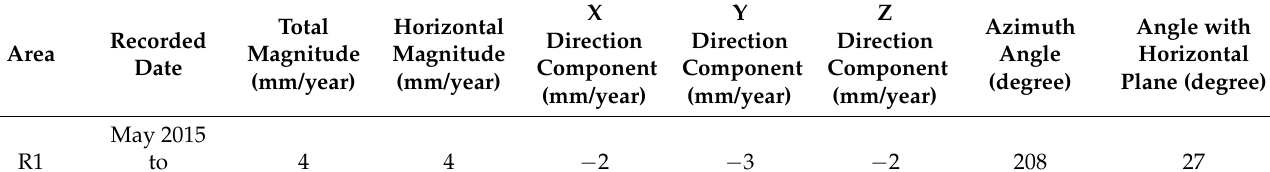
Figure 7. Calculated vertical component of R for selected cross-sections of the Goddard landslide. Table 3. Summary of calculated R magnitude and geometry for the Goddard landslide.